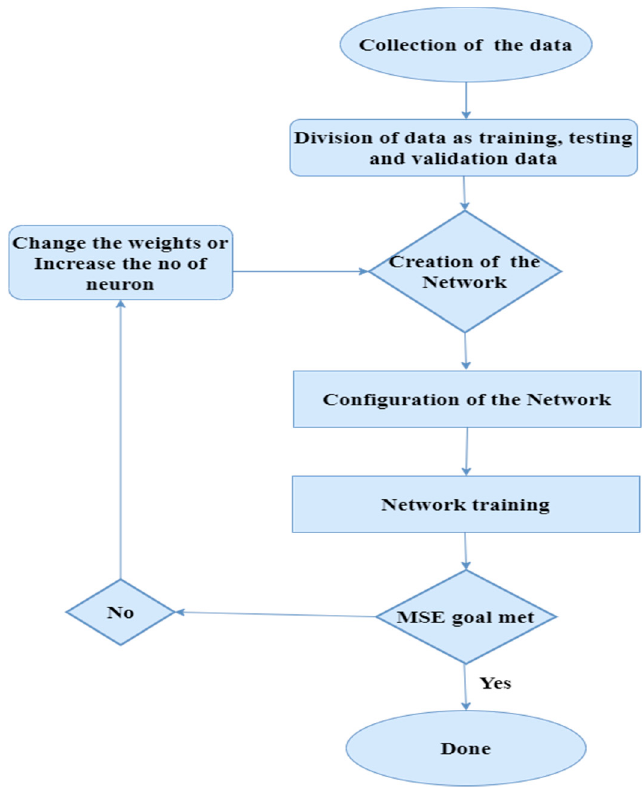
Figure 2. Proposed ANN model framework.